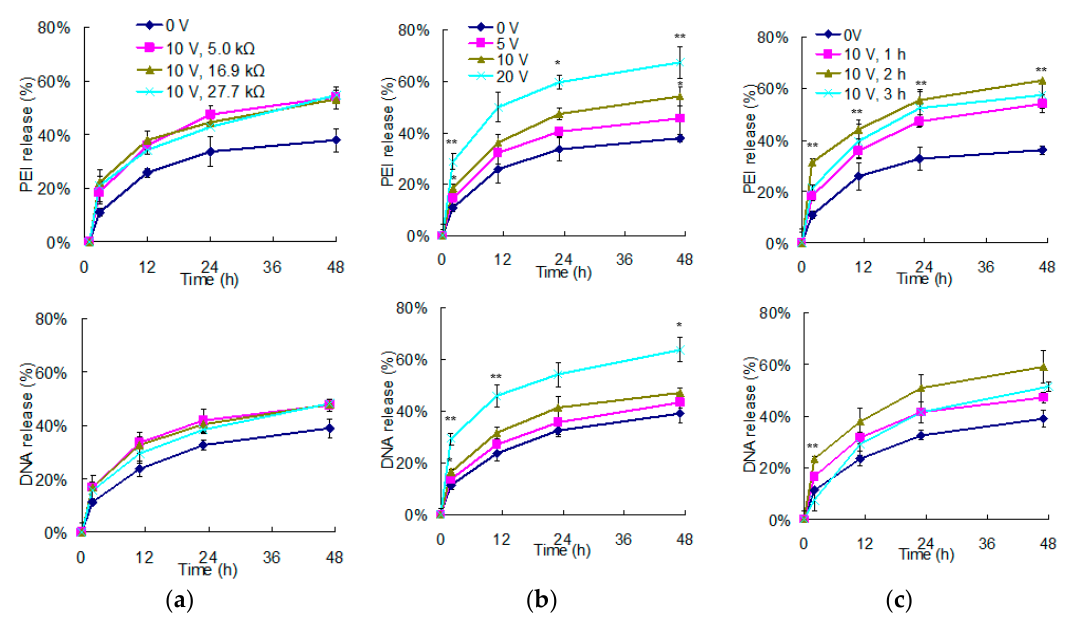
Figure 3. The effects of the parameters of the vertically electrical field pretreatment on polyelectrolyte delivery from PEMs. ( a ) Ten voltage of electrical fields pretreated PEMs on PPy films with different electrical resistances for 1 h to determine the effect of electric currents. ( b ) Different voltages pretreated PEMs for 1 h to determine the effect of intensity of electrical fields. ( c ) Electrical field in 10 V pretreated PEMs for di ff erent durations to determine the e ff ect of treatment duration. These electrical field-treated PEMs were monitored for their following delivery in aqueous environments for 48 h. ( n = 3. For ( b ), t -test compared to the results of the 5 V pretreating group at the same time, * p < 0.05; ** p < 0.01. For ( c ), t -test compared to the results of the 1 h pretreated group at the same time, ** p <